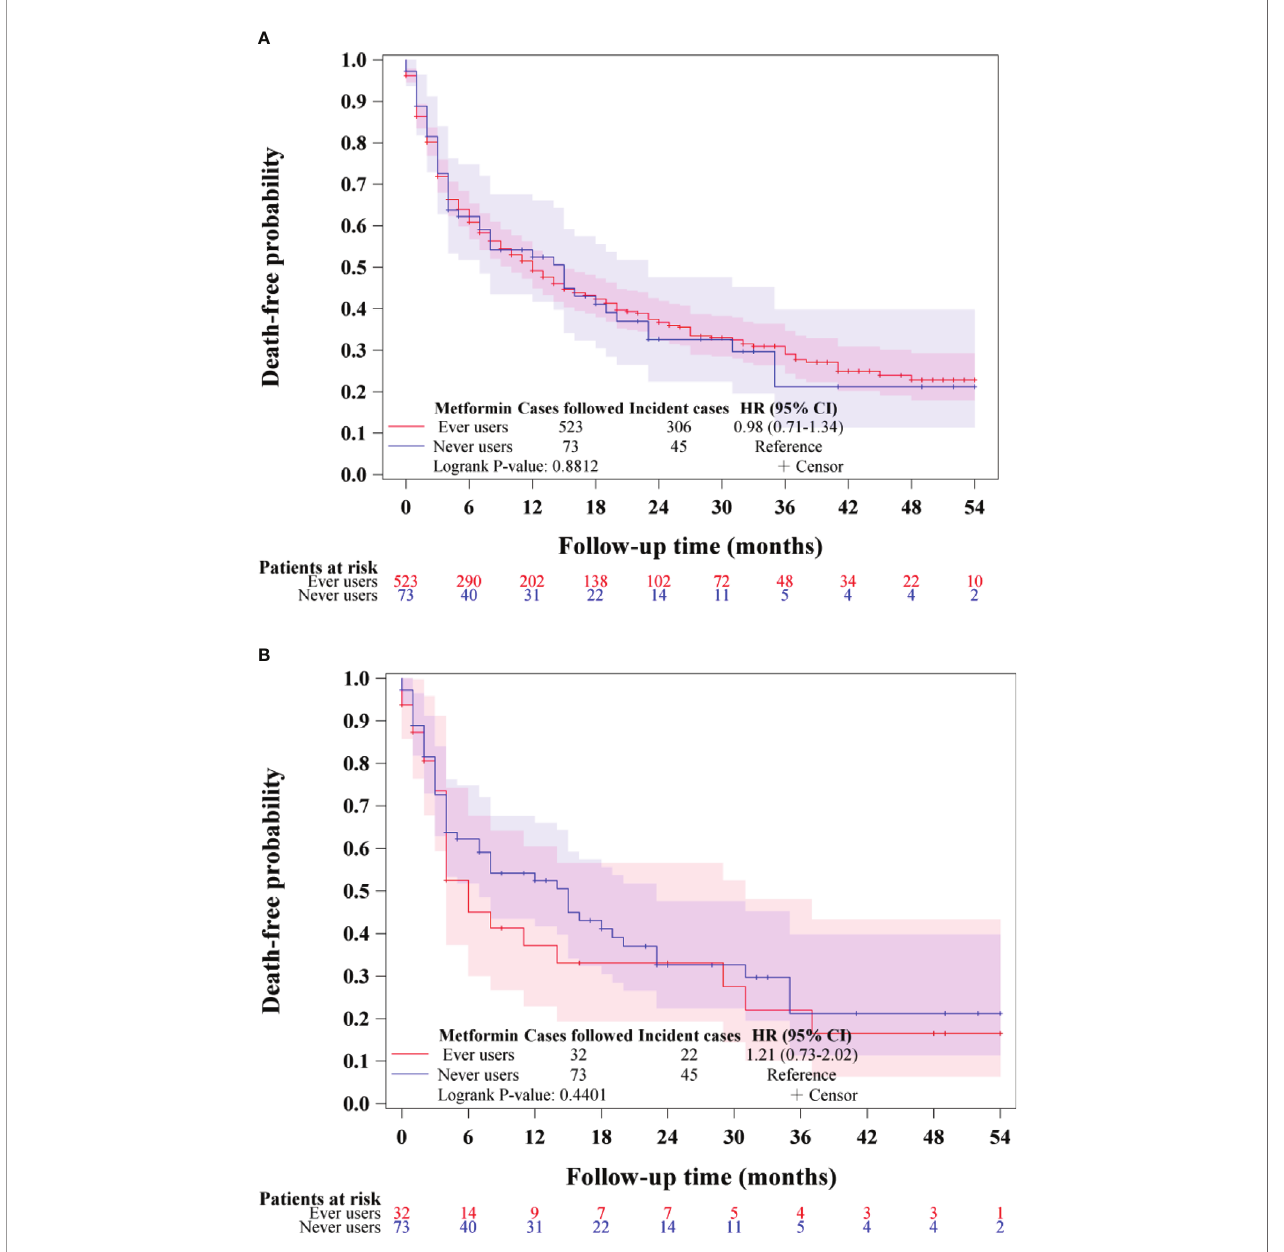
FIGURE 3 | Overall survival in patients with incident biliary tract cancer in ever users and never users of metformin in the unmatched cohort (A) and the matched cohort (B) . HR, hazard ratio; CI, con fi dence